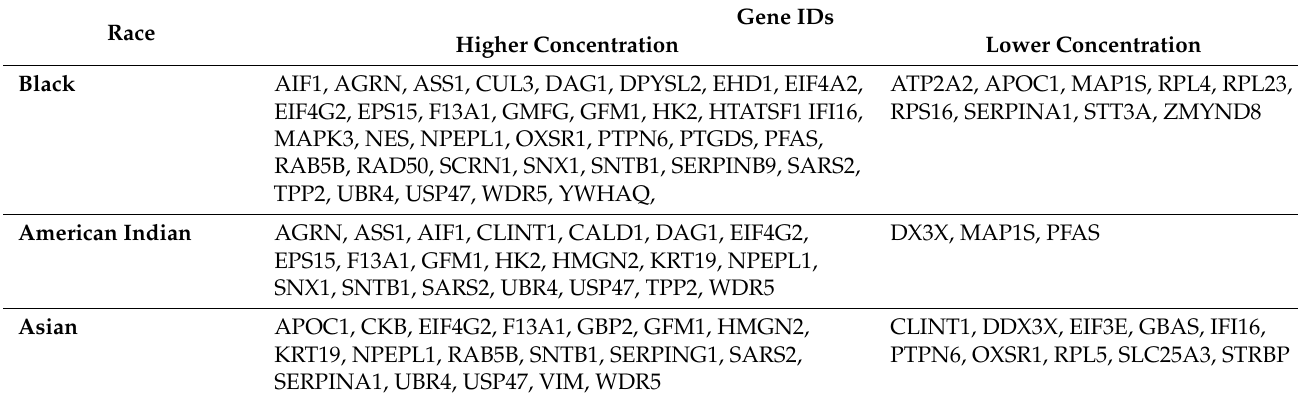
Table 2. List of gene IDs for proteins significantly different in endometrial cancer specimens from Black, American Indian and Asian racial groups compared to the White racial